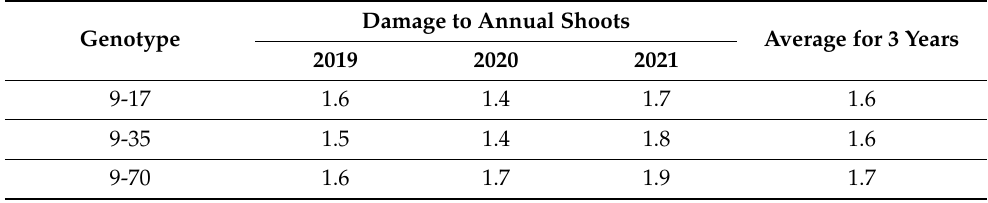
Table 3. Field assessment of raspberry hardiness (freezing